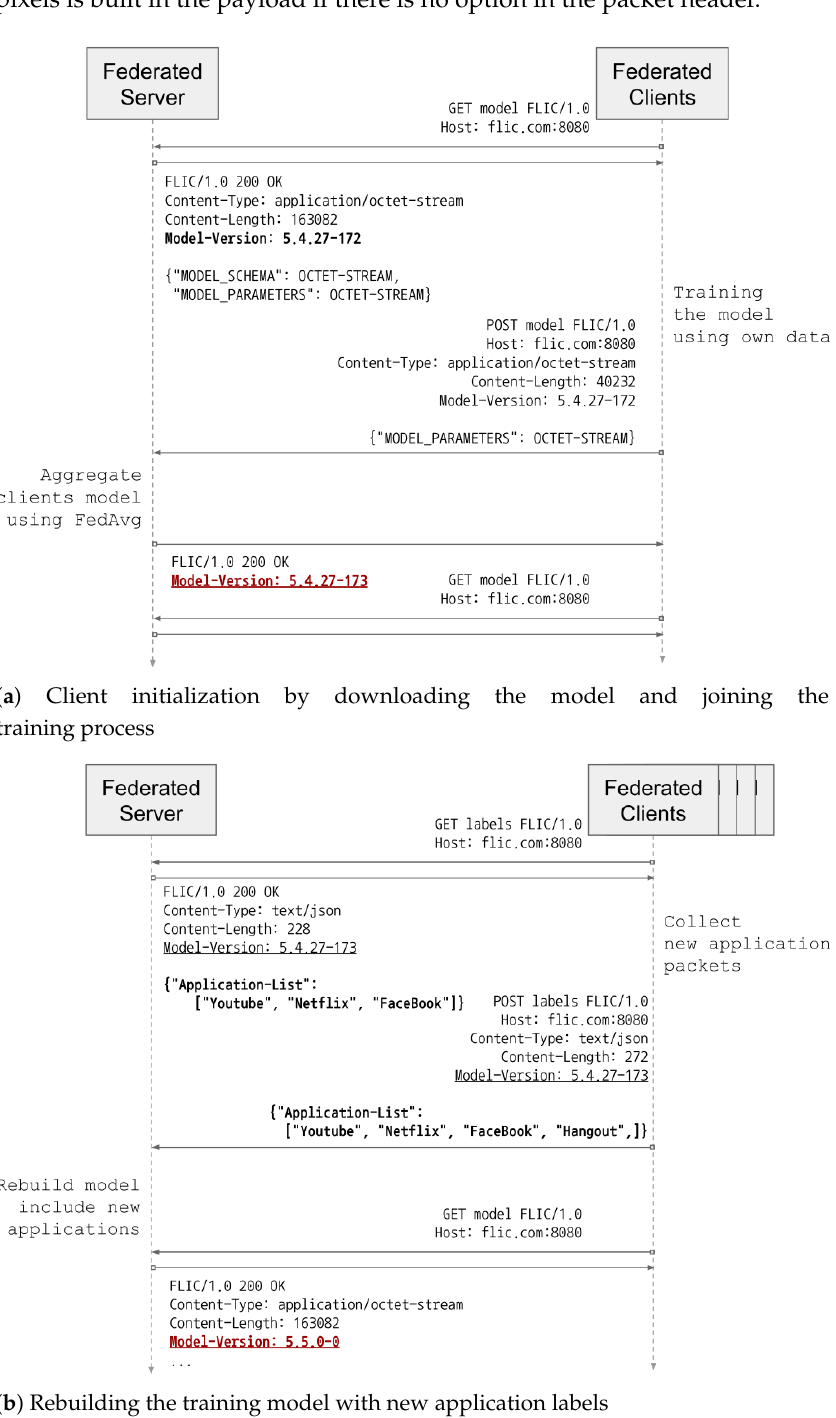
Figure 2. A federated-learning Internet traffic classification protocol (FLIC): initializing, updating, and rebuilding the training